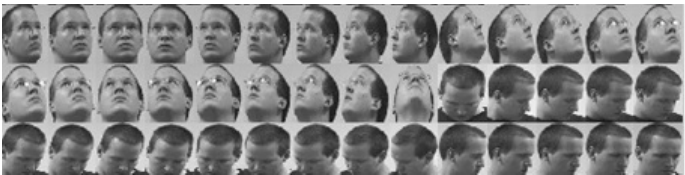
Figure 8. A subset of some images of one subject from the Head Pose database [59].